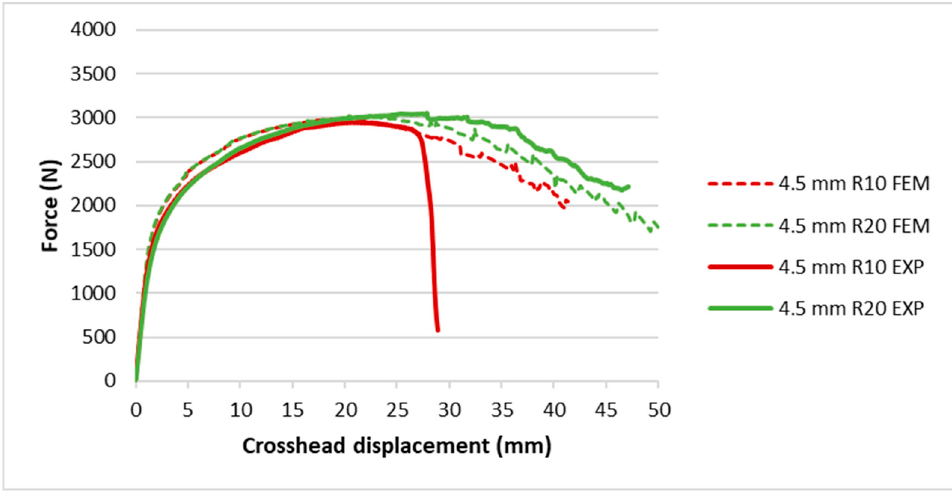
Figure 9. The correlation between FEM predicted and the experimentally measured relation be- tween the force and the cross-head displacement for 4 mm sheet.